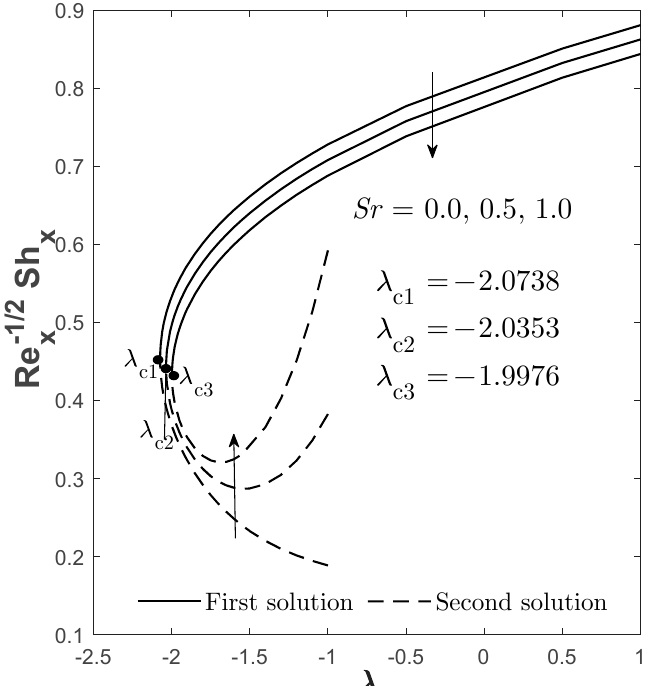
Figure 10. Figure 10. Re − 1/2 x Sh x for varied Sr when N = Rd = Sc = 1, φ 2 = 0.01, Du = 0.03, and Bi = 0.1. Figure 10.